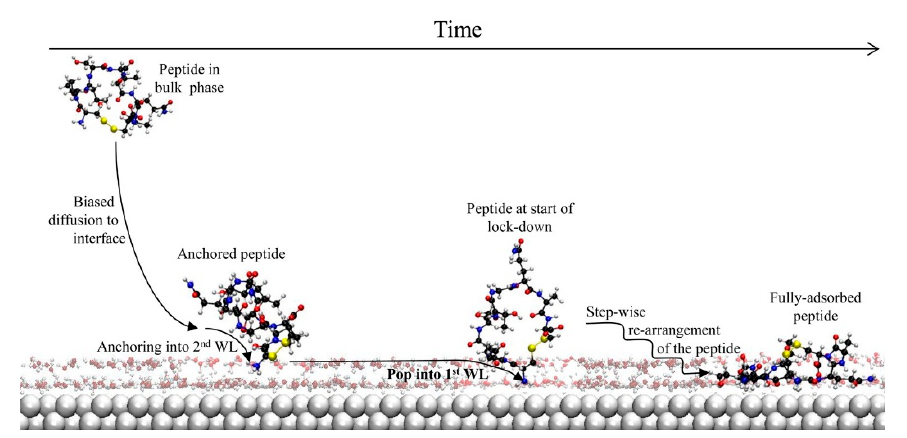
Figure 3. This illustration shows the simulations of proteins adsorbed on different surfaces. [74] . The first step is the biased diffusion towards the interface. The second step is the ‘anchoring’ of the peptide via a hydrophilic group of the peptide to the second water layer (WL) that occurs adjacent to the solid surface and finally the third step is the formation of the fully adsorbed peptide through a (‘lockdown’) process of stepwise rearrangement of the peptide that is initiated by the anchor group popping into the WL immediately adjacent to the surface.